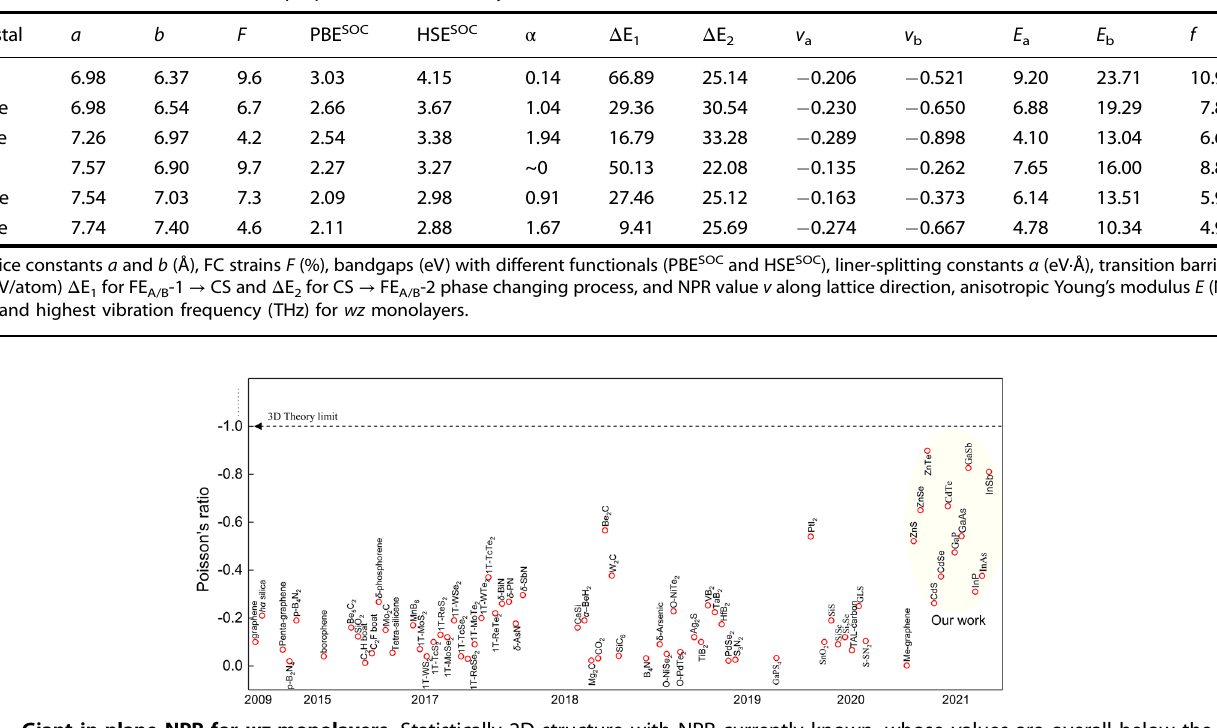
Table 1. Structural information and properties of wz monolayer.